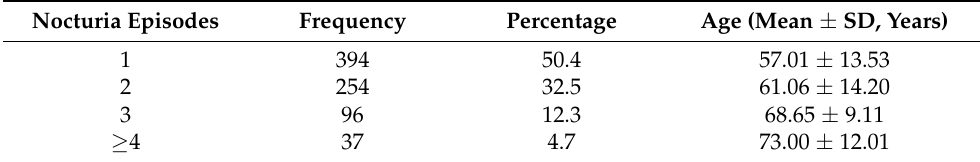
Table 2. Distribution and age of respondents reporting different voiding episodes per bedtime.